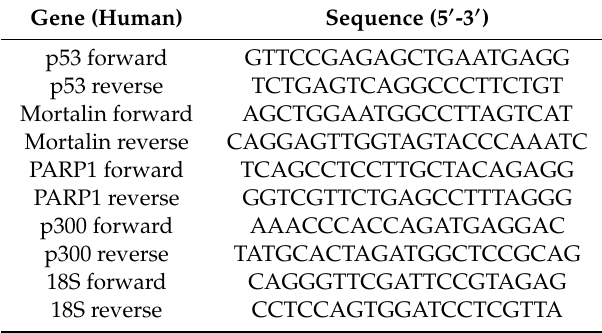
Table 1. Sequences of primers